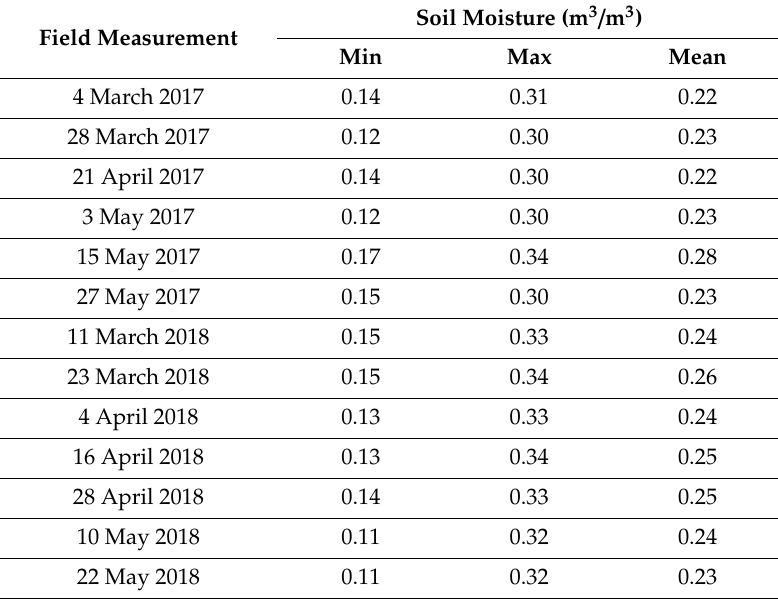
Figure 4. Observed soil moisture of each point during seven passes of the satellite estimated using the gravimetric method during 2018. Table 2. Observed soil moisture of all 62 samples combined during each pass of the satellite during 2017 and 2018 collected at Siruguppa taluk .